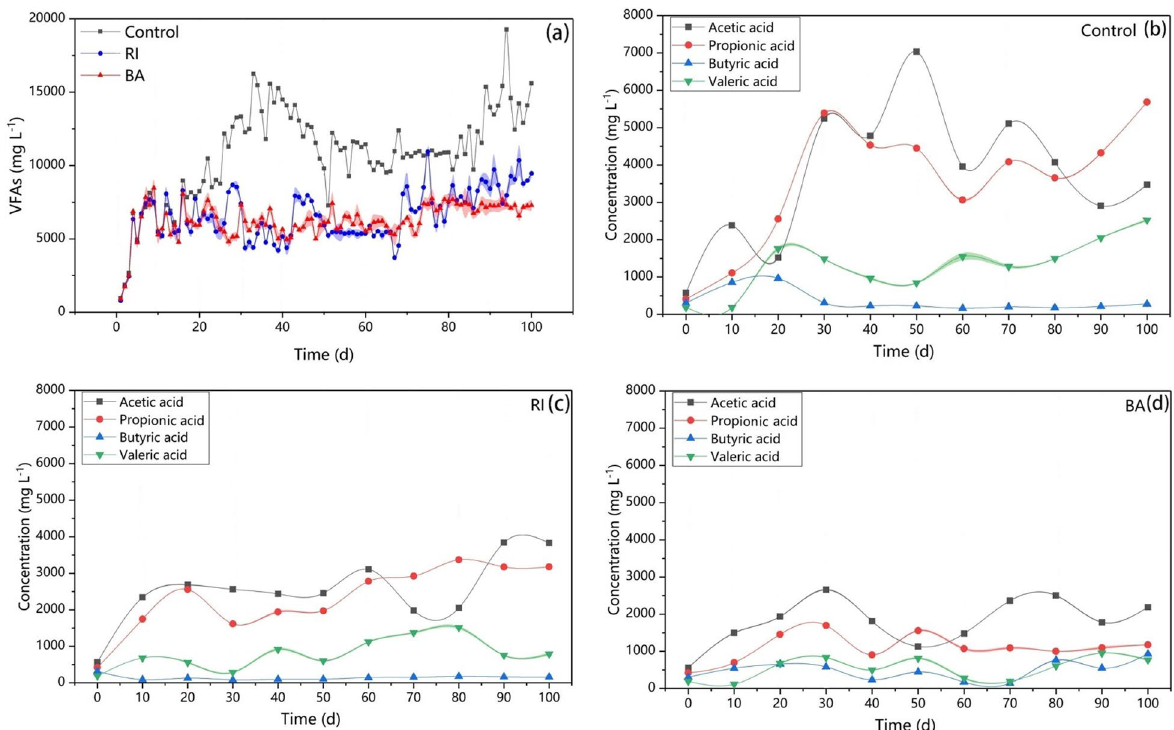
Fig. 4 Variations in VFAs concentrations ( a ) and compositions in different reactors: ( b ) Control reactor; ( c ) RI reactor, and ( d ) BA reactor. Shaded areas indicate error